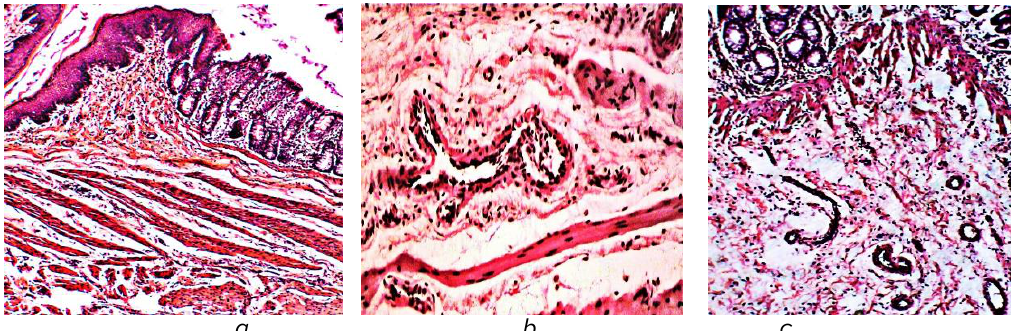
Fig. 5. Proximal wall of the rectal of the rat for 5 days after modeling of experimental hemorrhoids, stained with Hema- toxylin and Eosin: a – normal condition of the mucous membrane, hematoxylin and eosin ×100; b, c – lack of expan- sion and fullness of vessels of different caliber of the submucosal layer, hematoxylin and eosin